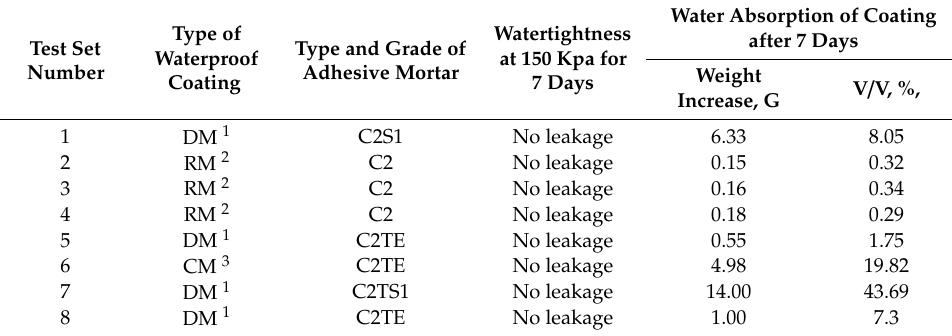
Table 1. Short characteristics of the products used in test